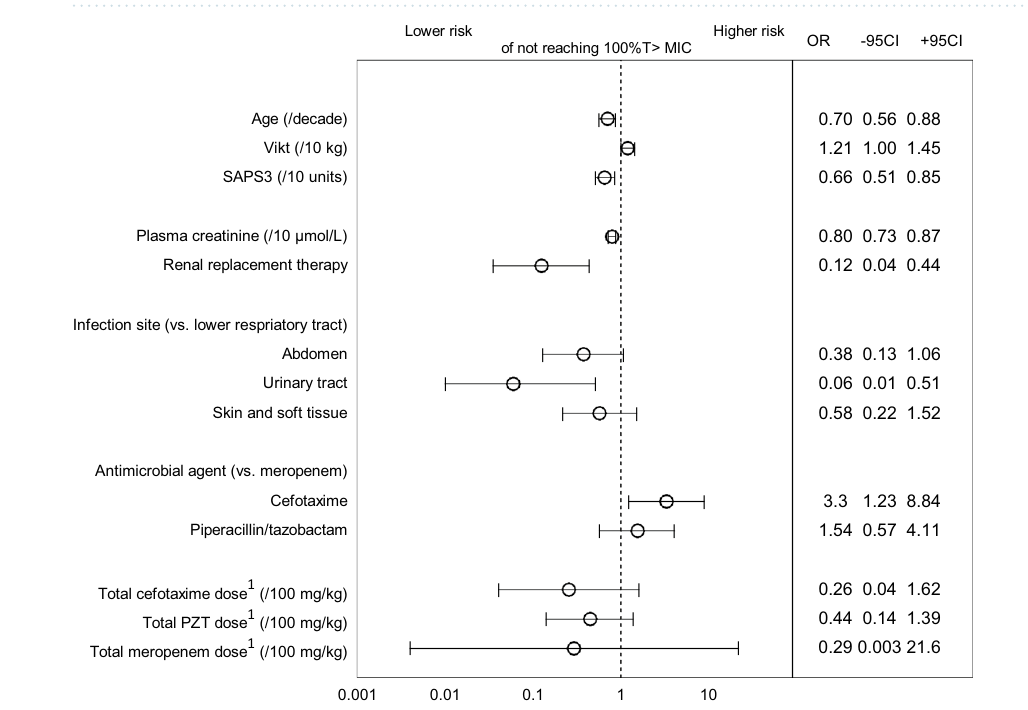
Figure 2. ( A ) Percentage achieved 100% T > MIC. ( B ) Percentage achieved 50% T > 4xMIC.